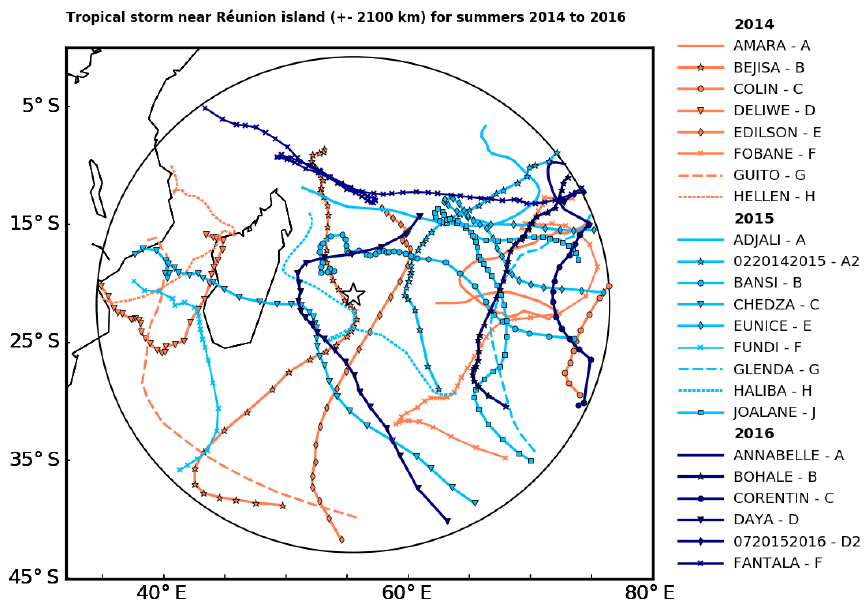
Figure 9. Map of best tracks of tropical cyclones for a range ring of 2100km around Réunion island. The best tracks of tropical cyclones during austral summer 2014 (November 2013 to April 2014) are shown in orange with different symbols for each tropical cyclone (TC); best tracks are in cyan for austral summer 2015 (November 2014–April 2015) and in blue for austral summer 2016 (November 2015–April 2016, in green). The yellow star indicates the location of Réunion